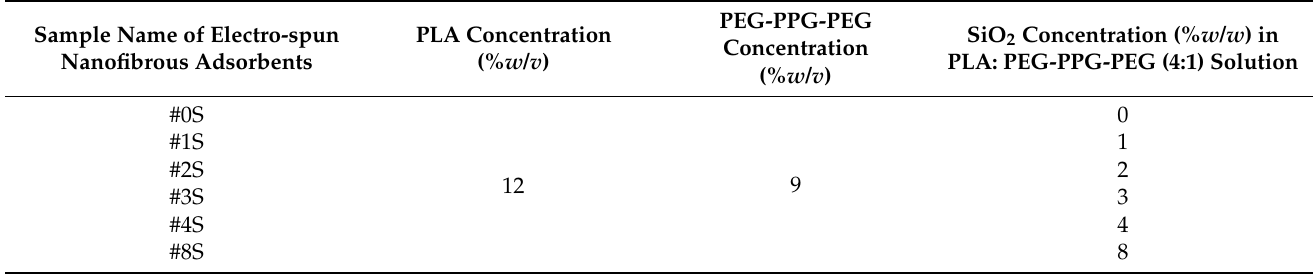
Table 1. The blending conditions of dope solutions for preparing PLA/PEG-PPG-PEG/SiO 2 nanofi- brous